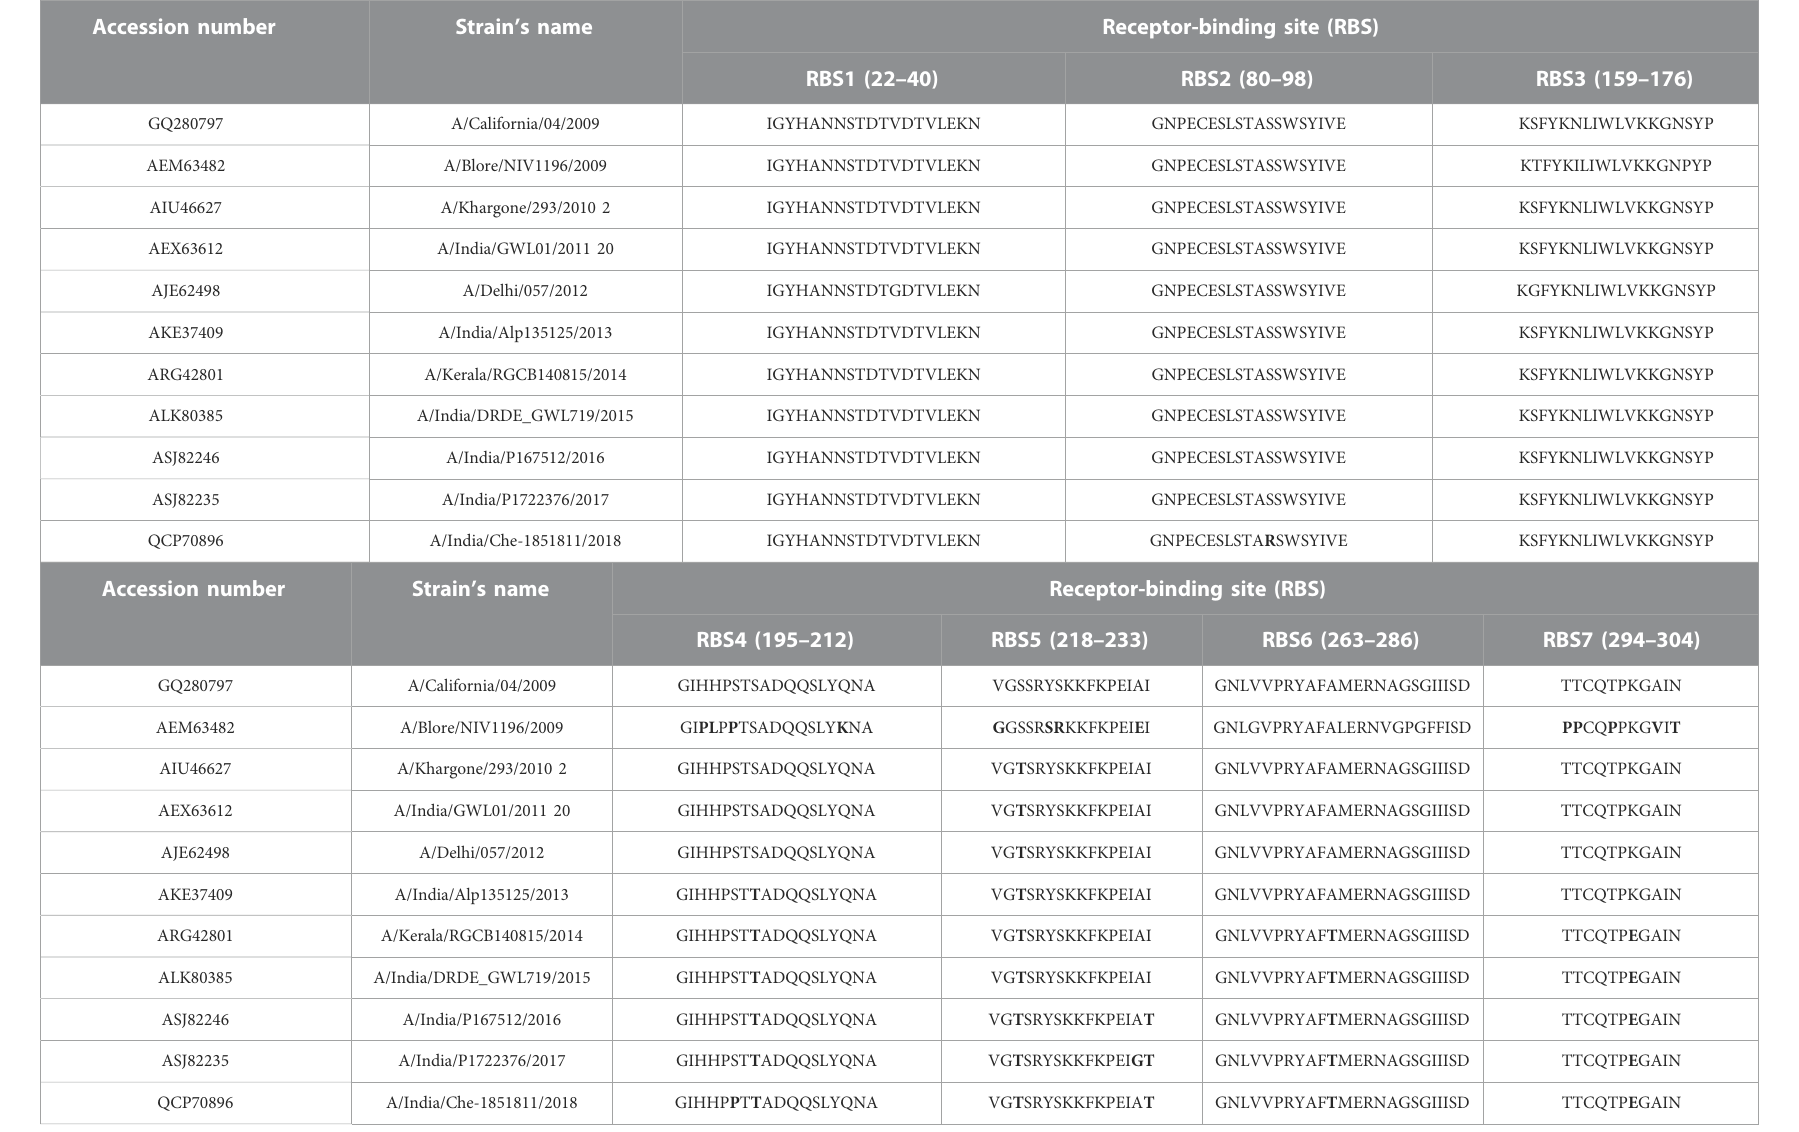
TABLE 4 Mutations at the RBS of HA Ind proteins (reported during 2009 – 2018) with reference to HA Cal are indicated in bold